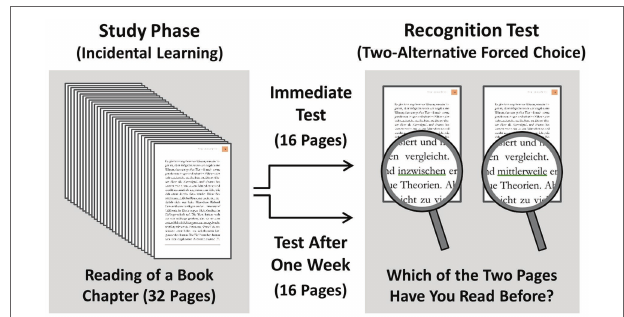
FIGURE 1 | Memory paradigm. Participants read a book chapter consisting of 32 pages (3,772 words) one single time on their own pace with the instruction to judge the didactic quality of the book chapter afterwards. No mention was made that their memory would be tested later. In a surprise memory test, verbatim memory for the book chapter was tested by asking the participants to remember exactly which word was written at a specific position